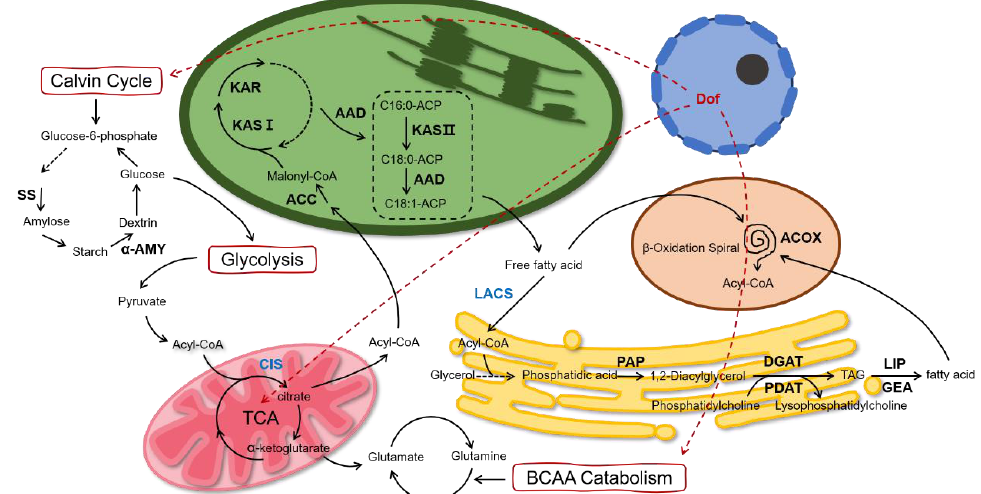
Figure 7. Schematic representation of the multiple regulations of DOF, LACS2, and